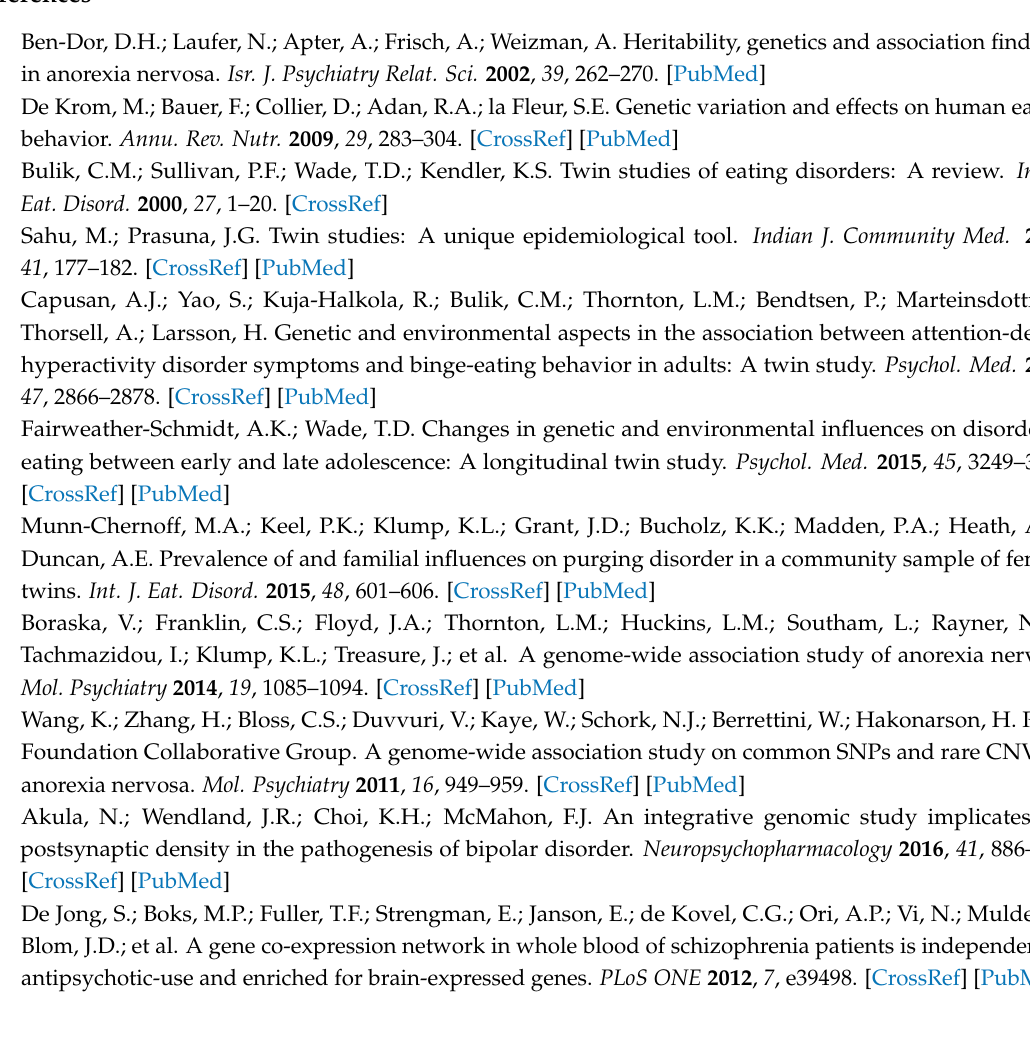
Figure S1: The quantities in the chosen columns vs. the soft threshold power, Figure S2: Heat map of differentially expressed genes. X-axis shows the cluster of cases (cluster 1) and controls (cluster 2), Y-axis shows the dendrogram of differentially expressed genes, Figure S3: a. Expression level of SLC32A1 between cases and controls, b. Expression level of HINT1 between cases and controls, c. Expression level of IFITM3 between cases and controls, d. Expression level of RELN between cases and controls, Figure S4: Protein-Protein Interaction Network structure of detected modules, a. Module yellow, b. Module turquoise, c. Module blue, d. Module brown, Table S1: Sample demographics; Table S2: Differentially expressed genes; Table S3: Functional enrichment of differentially expressed genes; Table S4: Functional enrichment of differentially expressed genes (MITHrIL); Table S5: Topological properties of the detected modules by WGCNA; Table S6: Functional enrichment of the WGCNA Modules., Table S7: Functional enrichment of the WGCNA Modules (MITHrIL), Table S8: Connectivity strength of intra-hub genes in the functional enriched modules. For module turquoise and blue (>100 genes), the top 10 connected genes ( k within ) were listed. For module brown and yellow (<100 genes), the top 5 connected genes ( k within ) were